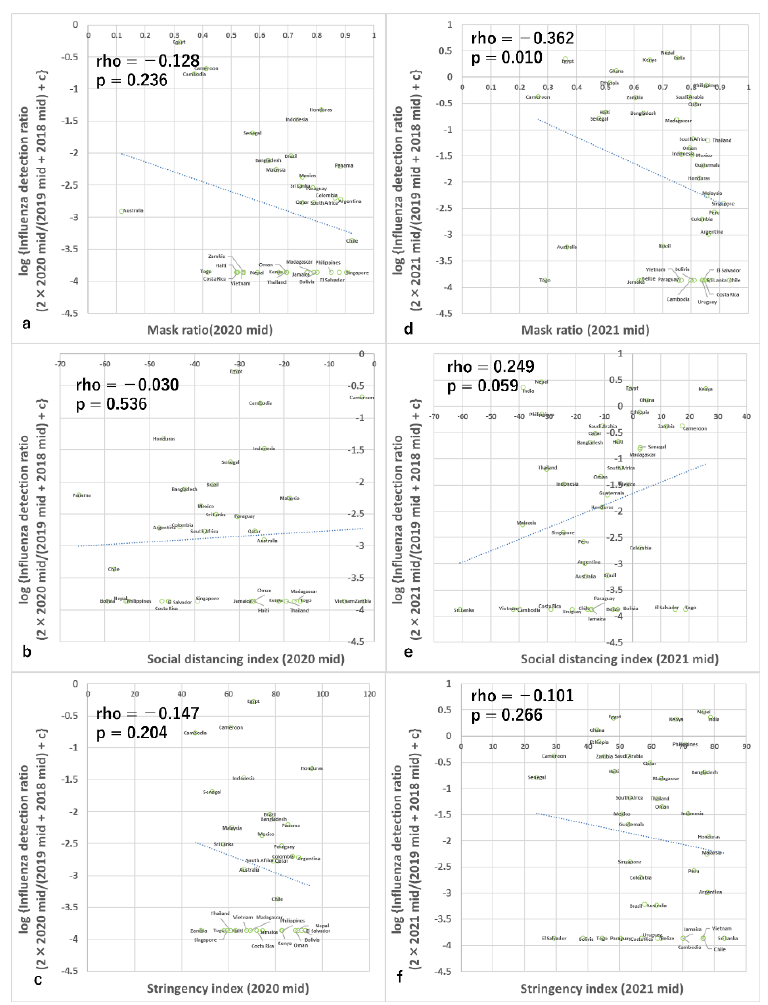
Figure 1. Association between infection control measures and influenza reduction in the mid-seasons. Association between influenza detection rate and ( a ) mask use in 2020, ( b ) social distancing index in 2020, ( c ) stringency index in 2020, ( d ) mask use in 2021, ( e ) social distancing index in 2021, and ( f ) stringency index in 2021. c in the y-axis is 0.0137. The p -value is Spearman’s simple correlation test with a one-tailed test. Rho is the correlation coefficient of non-parametric correlation analyses. Note the many data points of lowest value of y axis in all the panels correspond to no detection of influenza during the period according to the conversion